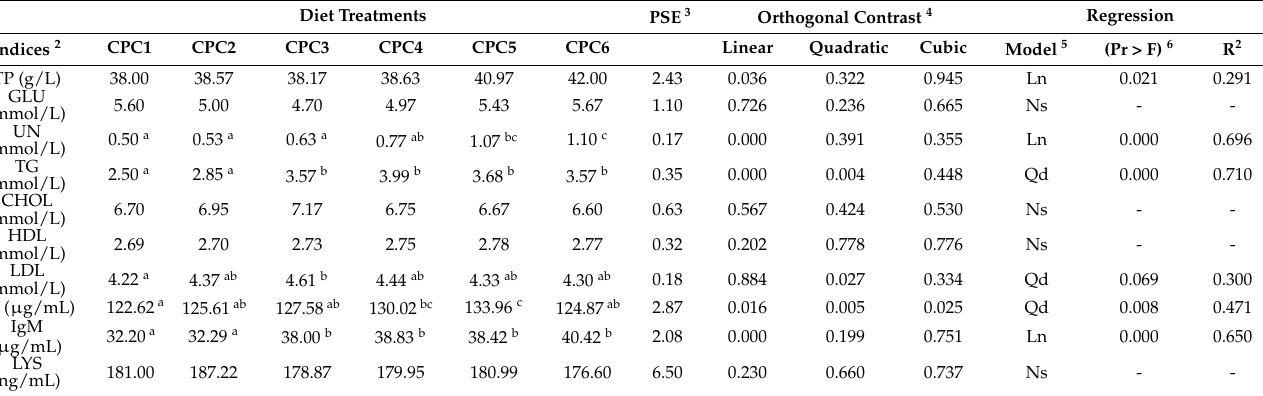
Table 5. Effects of dietary protein levels on biochemical indices and immune parameters in the serum of grass carp 1